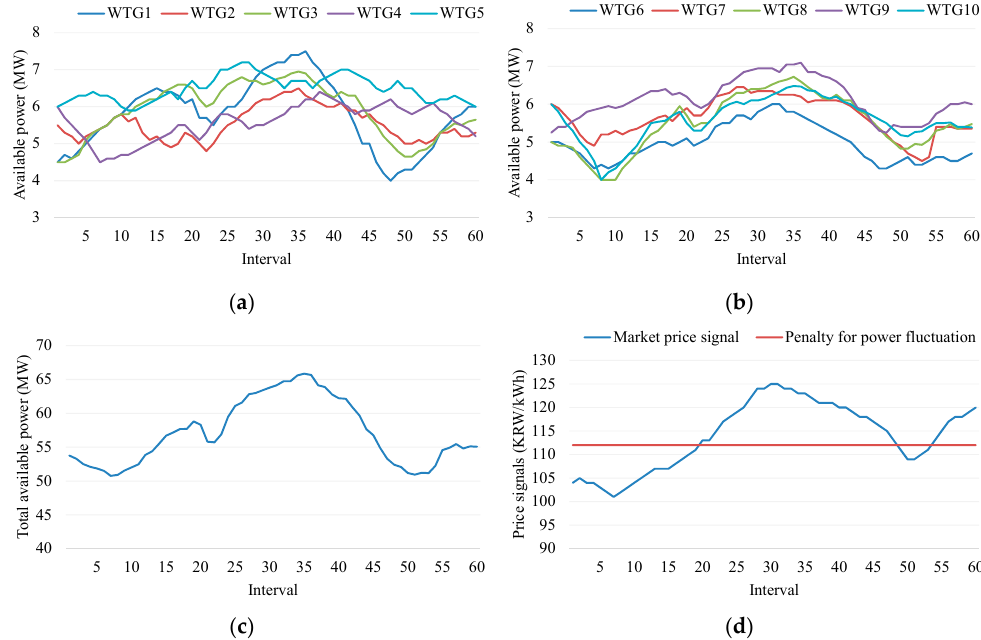
Figure 6. Input data: ( a ) Available power generation of WTGs in cluster 1; ( b ) Available power generation of WTGs in cluster 1; ( c ) Available power generation of the WF system; ( d ) Market price signals.